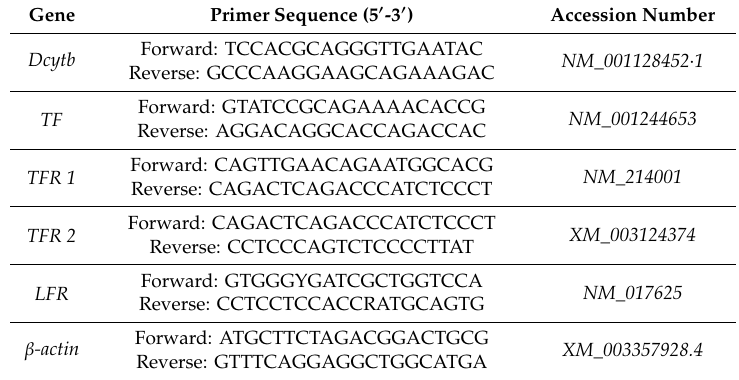
Table 1. Primers used for real-time quantitative PCR analysis of Dcytb, TF, TFR1, TFR2, LFR and β -actin . Gene Primer Sequence (5 (cid:48) -3 (cid:48)